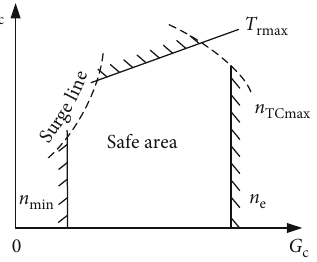
Figure 6: Schematic diagram of the safe working area for the turbocharging system and its safety boundaries.